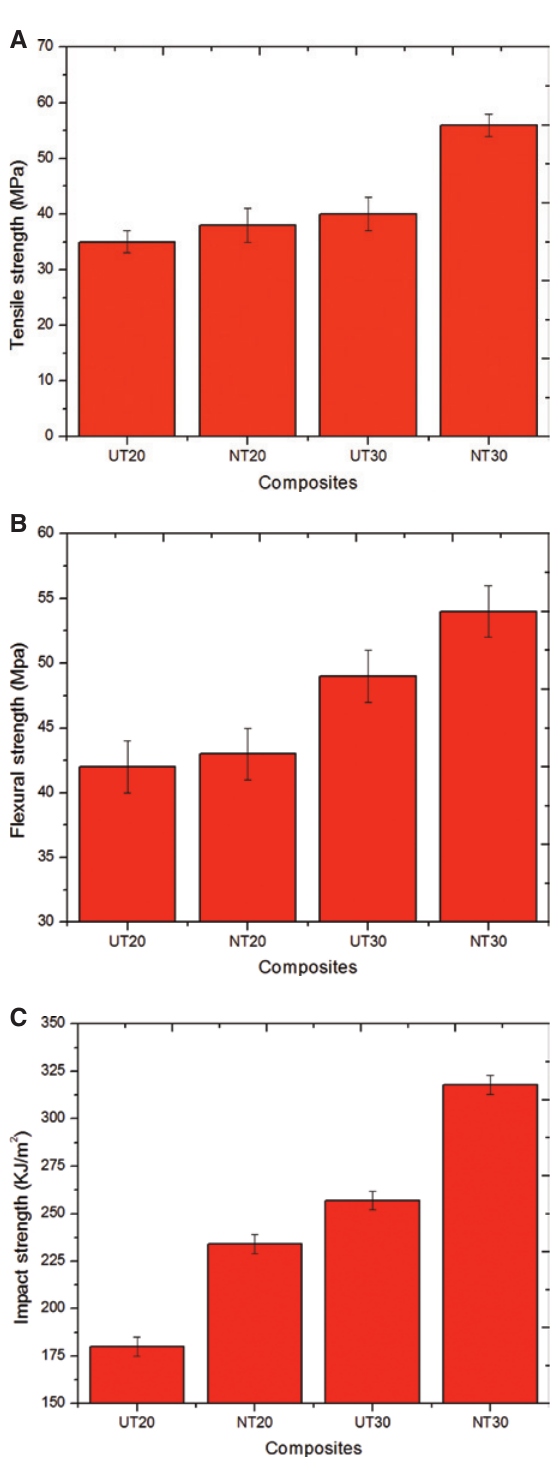
Figure 4 Effect of alkali treatment on tensile (A), flexural (B) and impact strength (C) of fabricated composites.